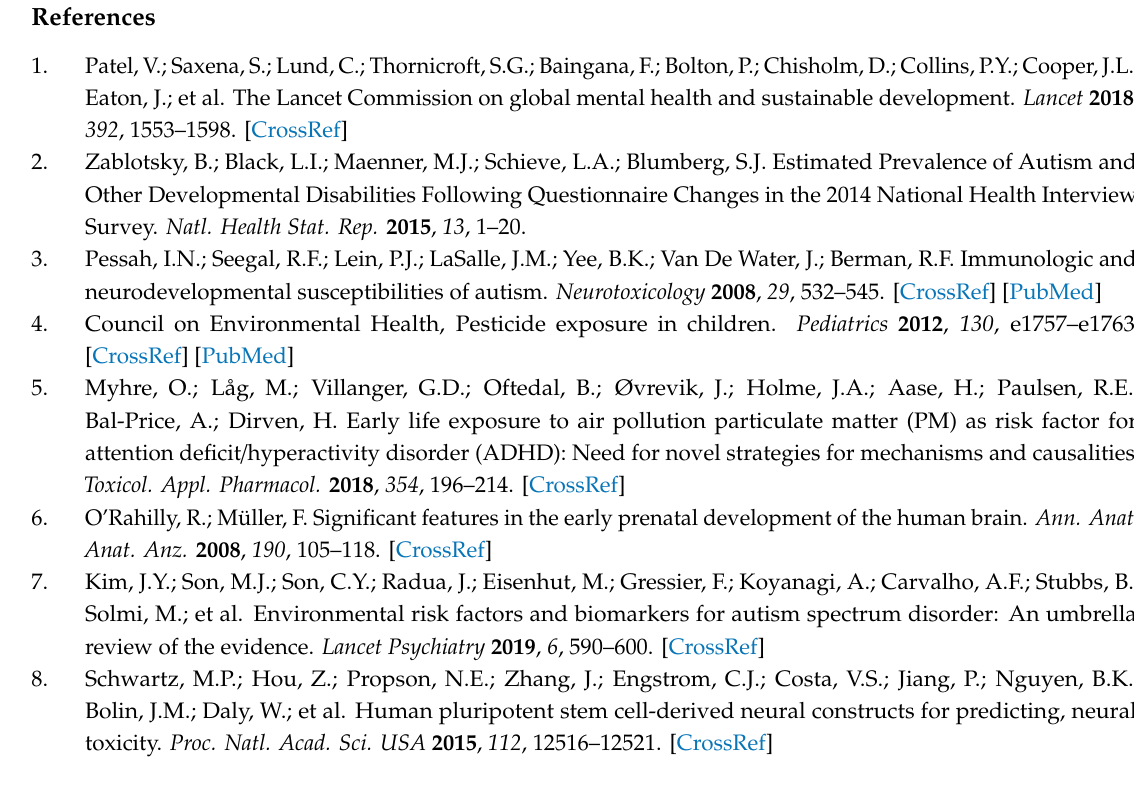
5564 / s1. Figure S1: E ff ects of chemical exposure on cellular morphologies and MAP2 gene expression during the neuronal di ff erentiation from human embryonic stem cell (hESC)-derived spheres. Figure S2: Synaptogenesis Signaling Pathway. Figure S3: Upstream causal network. Figure S4: Representative network with probability values in Bayesian network analysis. Networks were generated based on the TAO-Gen algorithm using the web-based RX-Taogen software. Table S1: Lists of the TMD-specific genes selected after the comparison between TMD and each of the three chemicals correspondingly for IPA-pathway analysis. Table S2: Prediction of expression patterns of genes involved in the function of “Di ff erentiation of embryonic cells” by